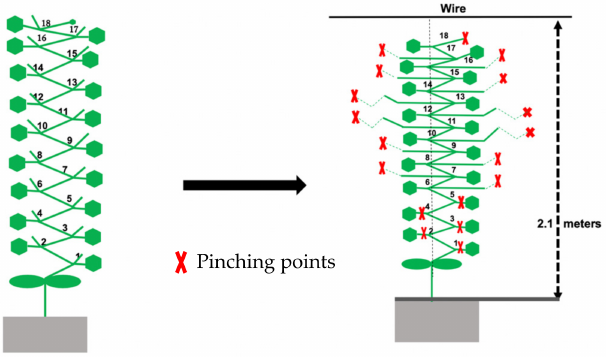
Figure 2. Pinching training method.